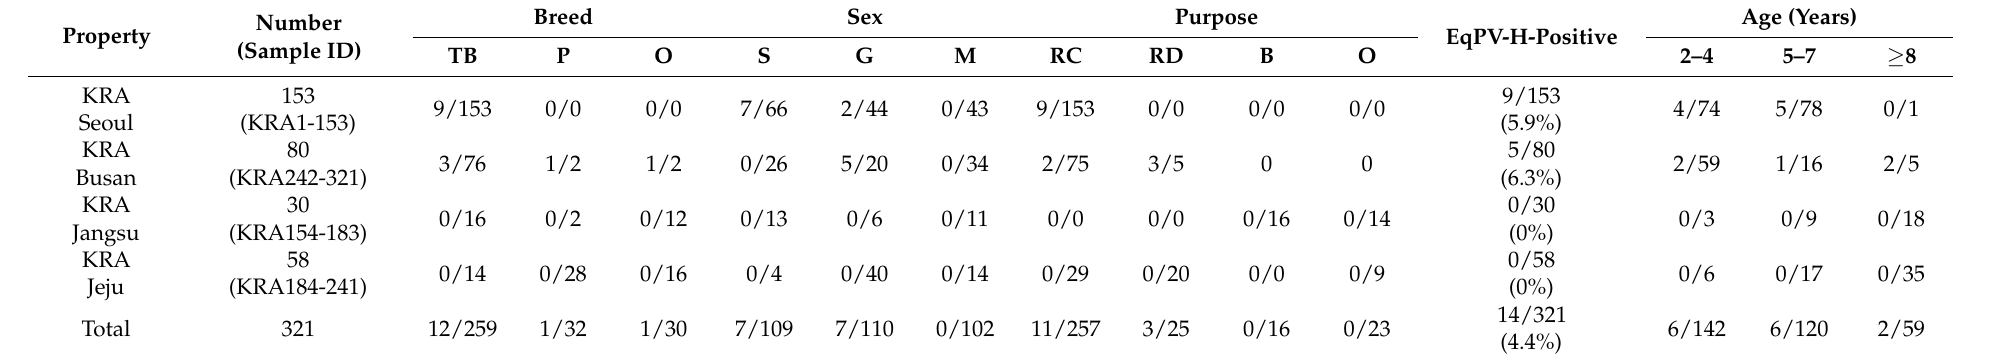
Table 1. Detailed information of property location, number, breed, purpose, and age of equine samples tested for equine parvovirus-hepatitis (EqPV-H) in South Korea.